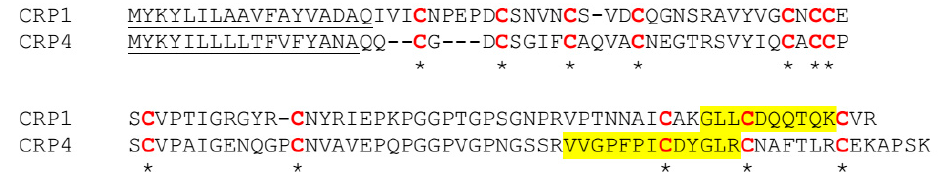
Figure 1. Amino acid sequence alignment of black widow CRP1 and CRP4. Single letter designations represent amino acid residues, while the underlined regions depict the secretion signal predicted by SignalP 4.1 (DTU Bioinformatics). Red letters or asterisks show conserved Cys (C) residues. Dashes represent an insertion to optimize protein alignments. Highlighted yellow regions correspond to select peptides identified by MS/MS analysis (see Figure 3).